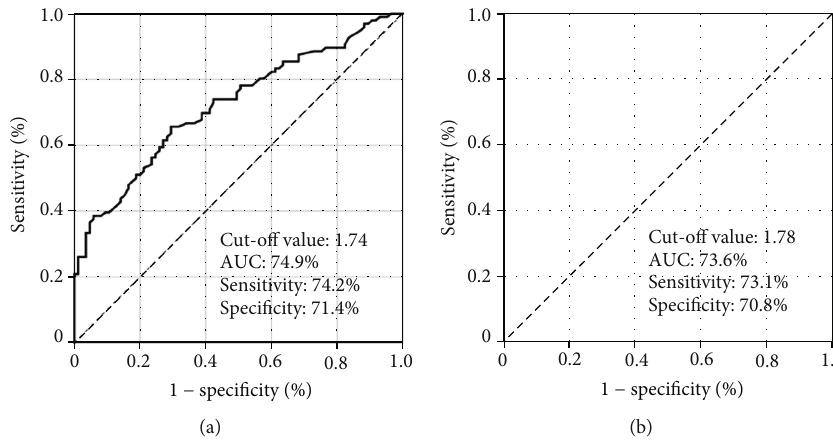
Figure 1: Results of the receiver-operating characteristic curve analysis for disease-free- and overall survival status. Table 2: Treatment characteristics and clinical